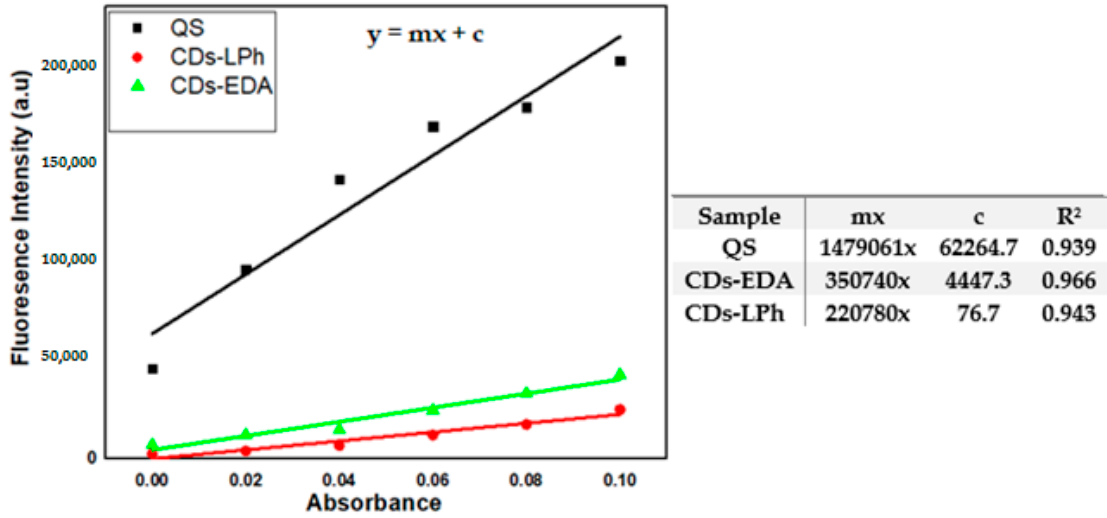
Figure 5. Fluorescence intensity plot of quinine sulfate (QS), CDs-EDA, and CDs-LPh against absorbance. Inset is the value of parameters of equation for the straight-line plot.